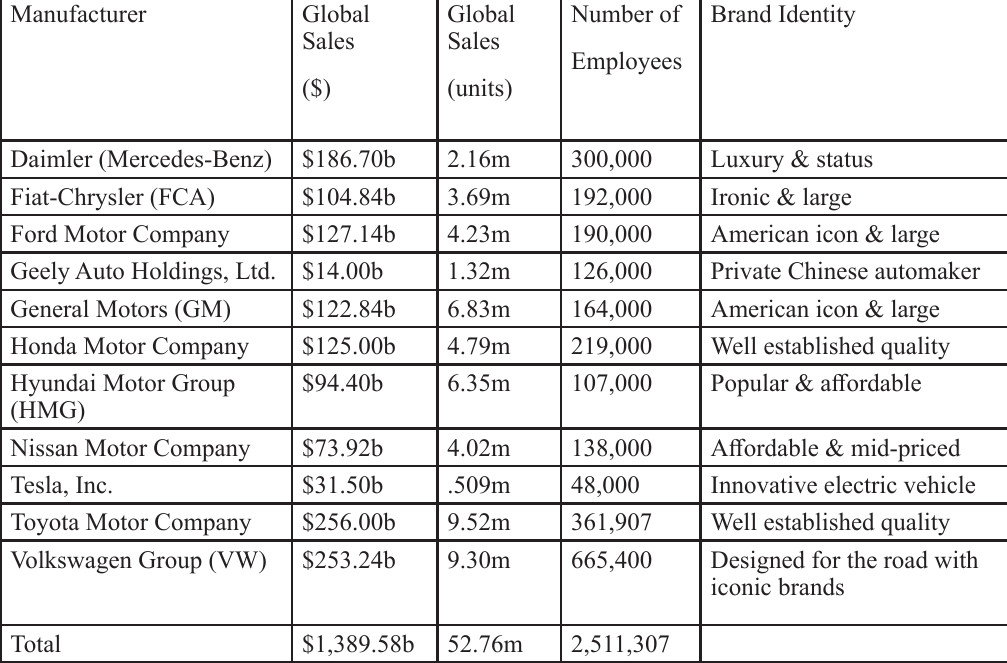
Table 1: Characteristics of Eleven Global Vehicle Makers for 2020